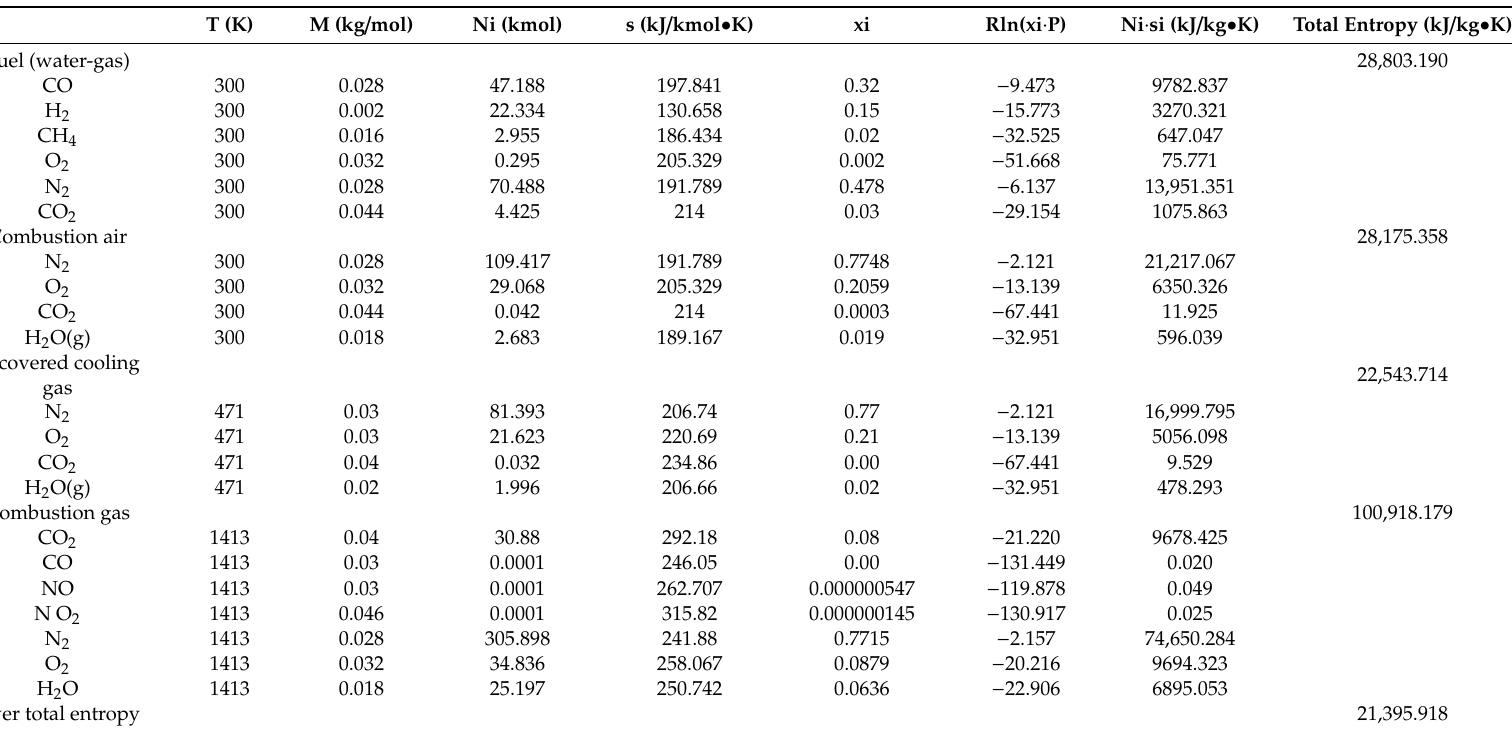
Table 10. Entropy generation in the combustion